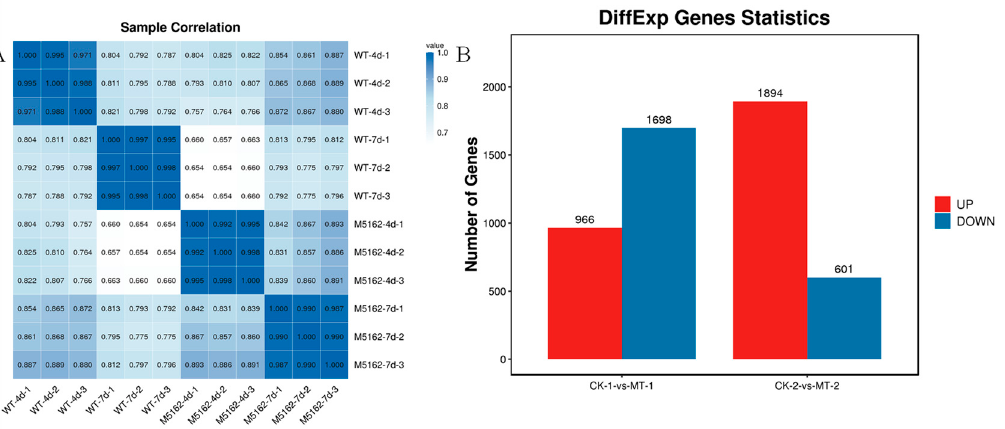
Figure 6. Pearson correlation coefficient analysis of RNA-seq data from parent strain and mutant